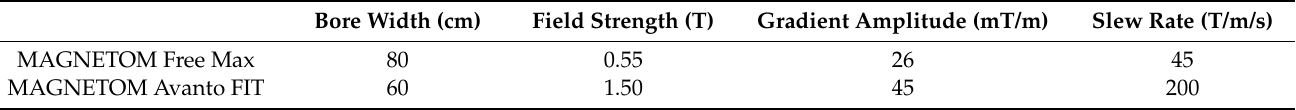
Figure 2. Sample pictures of the examination rooms of the Siemens MAGNETOM FreeMax 0.55T (left side) and Siemens MAGNETOM Avanto Fit 1.5T (right side). Table 1. Specifications of 0.55T and 1.5T MR scanner